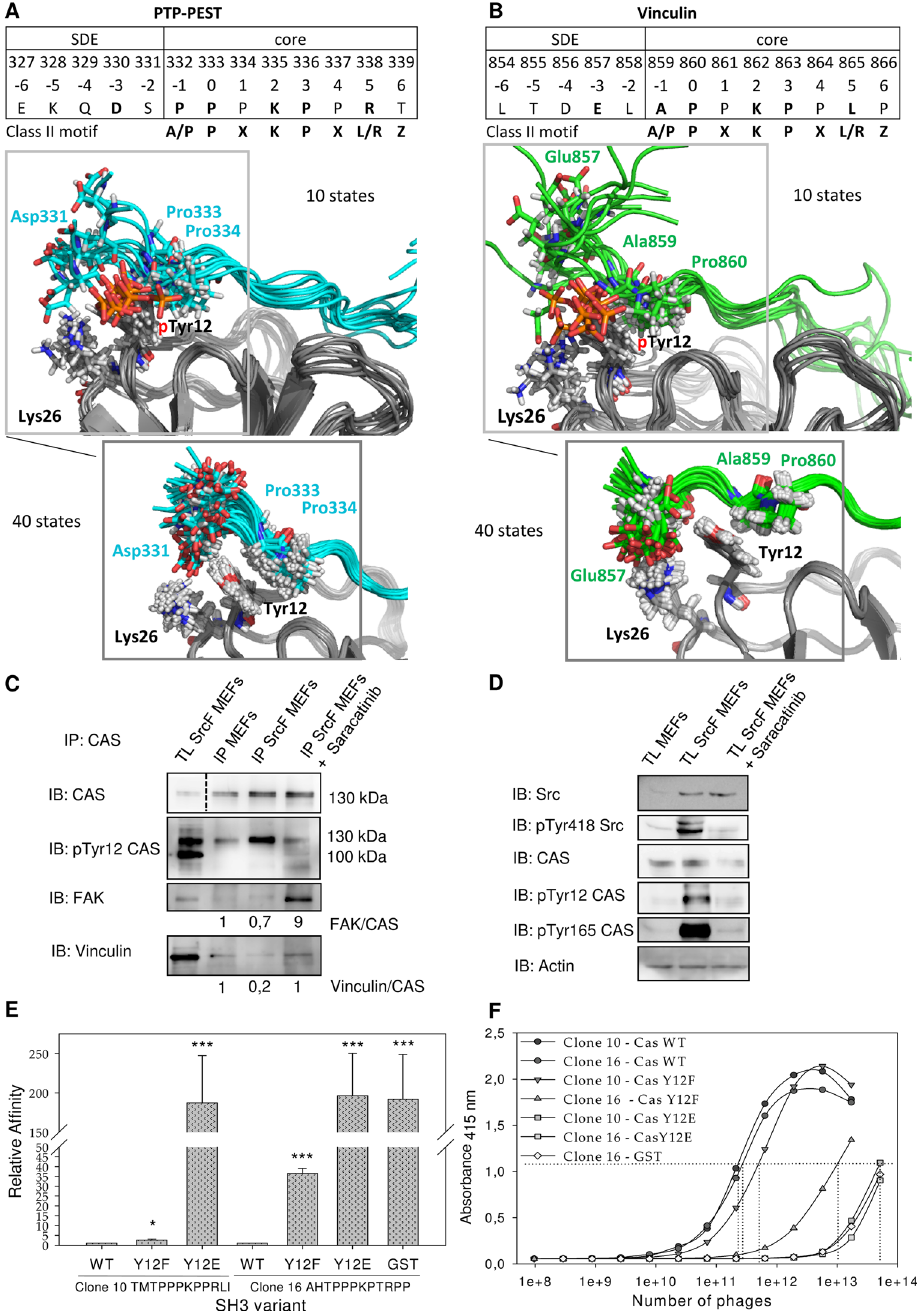
Figure 7. Src phosphorylation of CAS on Tyr12 inhibits CAS binding to FAK and Vinculin. Ten structures from molecular dynamics of phosphoTyr12 CAS SH3 with ( A ) PTP-PEST peptide (cyan) and ( B ) Vinculin peptide (green) are shown. These are compared with 40 NMR structures of unphosphorylated CAS SH3 complexes. ( C ) Co-precipitation analysis of the effect of Src activity on CAS binding capacity. CAS was immunoprecipitated from MEFs and from Src-transformed (SrcF) MEFs (in presence or absence of 5 µ M saracatinib), and the amount of co-precipitated FAK and vinculin was analyzed. Numbers indicate the fold-change in ratio of FAK or Vinculin coimmunoprecipitated with CAS. ( D ) Immunoblot analysis of the effect of Src activity on CAS phosphorylation. ( C , D ) Blots were cropped from original full-size images (see Supplemental Material). ( E ) Quantification of phage-displayed peptides (clone 10 and clone 16) binding to CAS SH3 variants (WT, Y12F, Y12E) fused with GST or GST alone. The relative affinity represents the binding ratio relative to CAS-WT. The data are expressed as average ± standard deviation from three independent experiments. Statistical significance ( * p < 0.05, *** p < 0.001) was determined on log-transformed data by one-way repeated-measures ANOVA followed by Tukey’s post-hoc test. ( F ) Representative curves of phage-displayed peptides (clone 10 and clone 16) binding to CAS SH3 variants (WT, Y12F, Y12E) fused to GST or GST. GST alone with phage clone 16 was used as a negative